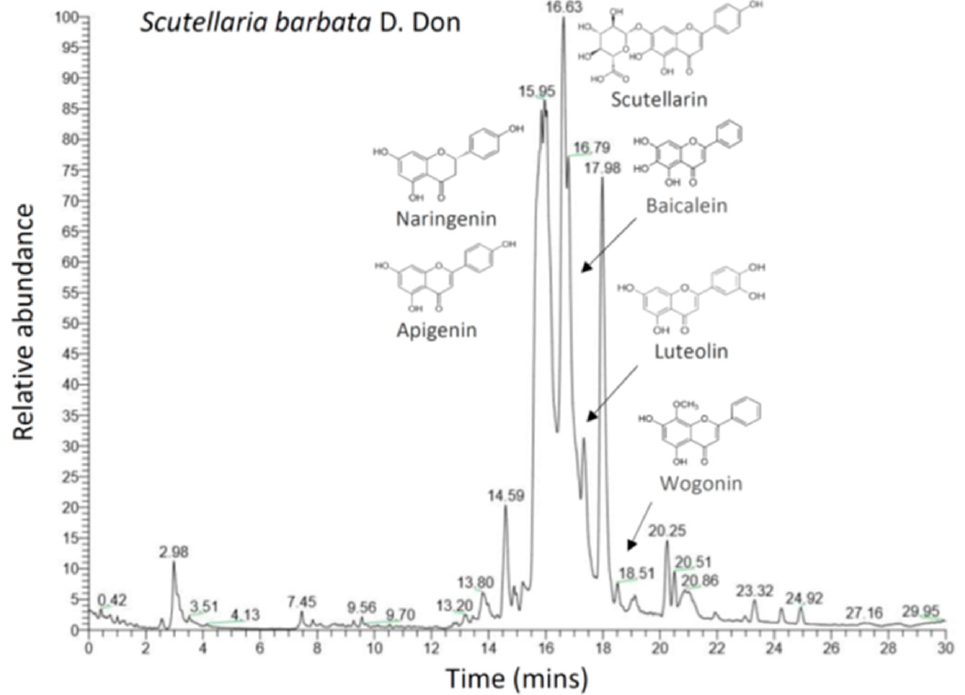
Figure 5. The fingerprint of Scutellaria barbata. Aqueous extracts of Scutellaria barbata was analyzed by LC/MS. The main compositions of individual herbal compounds were indicated by arrows based on the exact molecular weight.